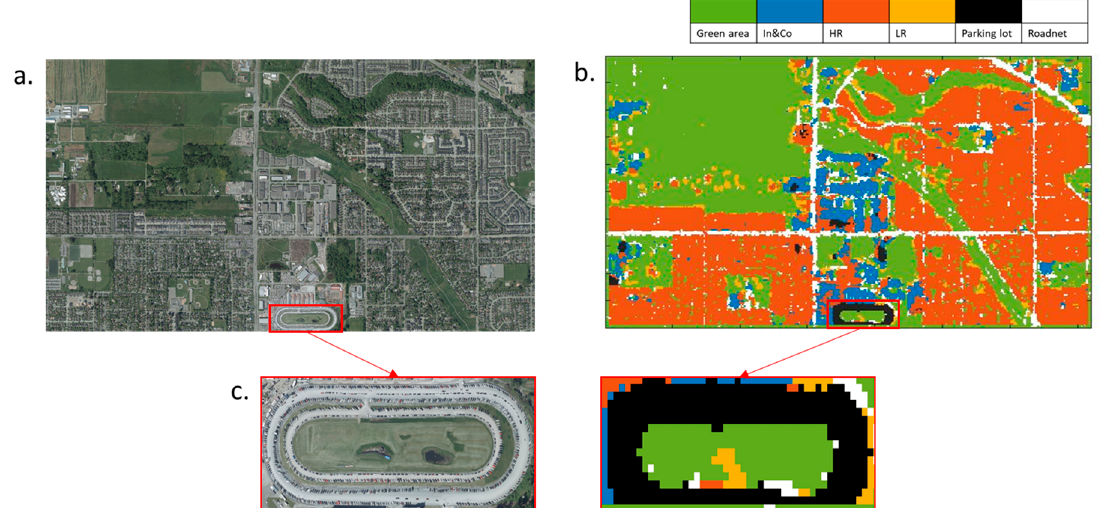
Figure 8. ( a ) The orthophoto image of the study area with ( b ) the digital land-use map based on classification results for the year 2017. (1) Green area (GA), green color; (2) industrial and commercial areas (In&Co), blue color; (3) high-density residential areas (HR), red color; (4) low-density residential areas (LR), yellow color; (5) parking lot (PL), black color; (6) road network (RN), white color. ( c ) Detailed image of the zone with the field track filled with